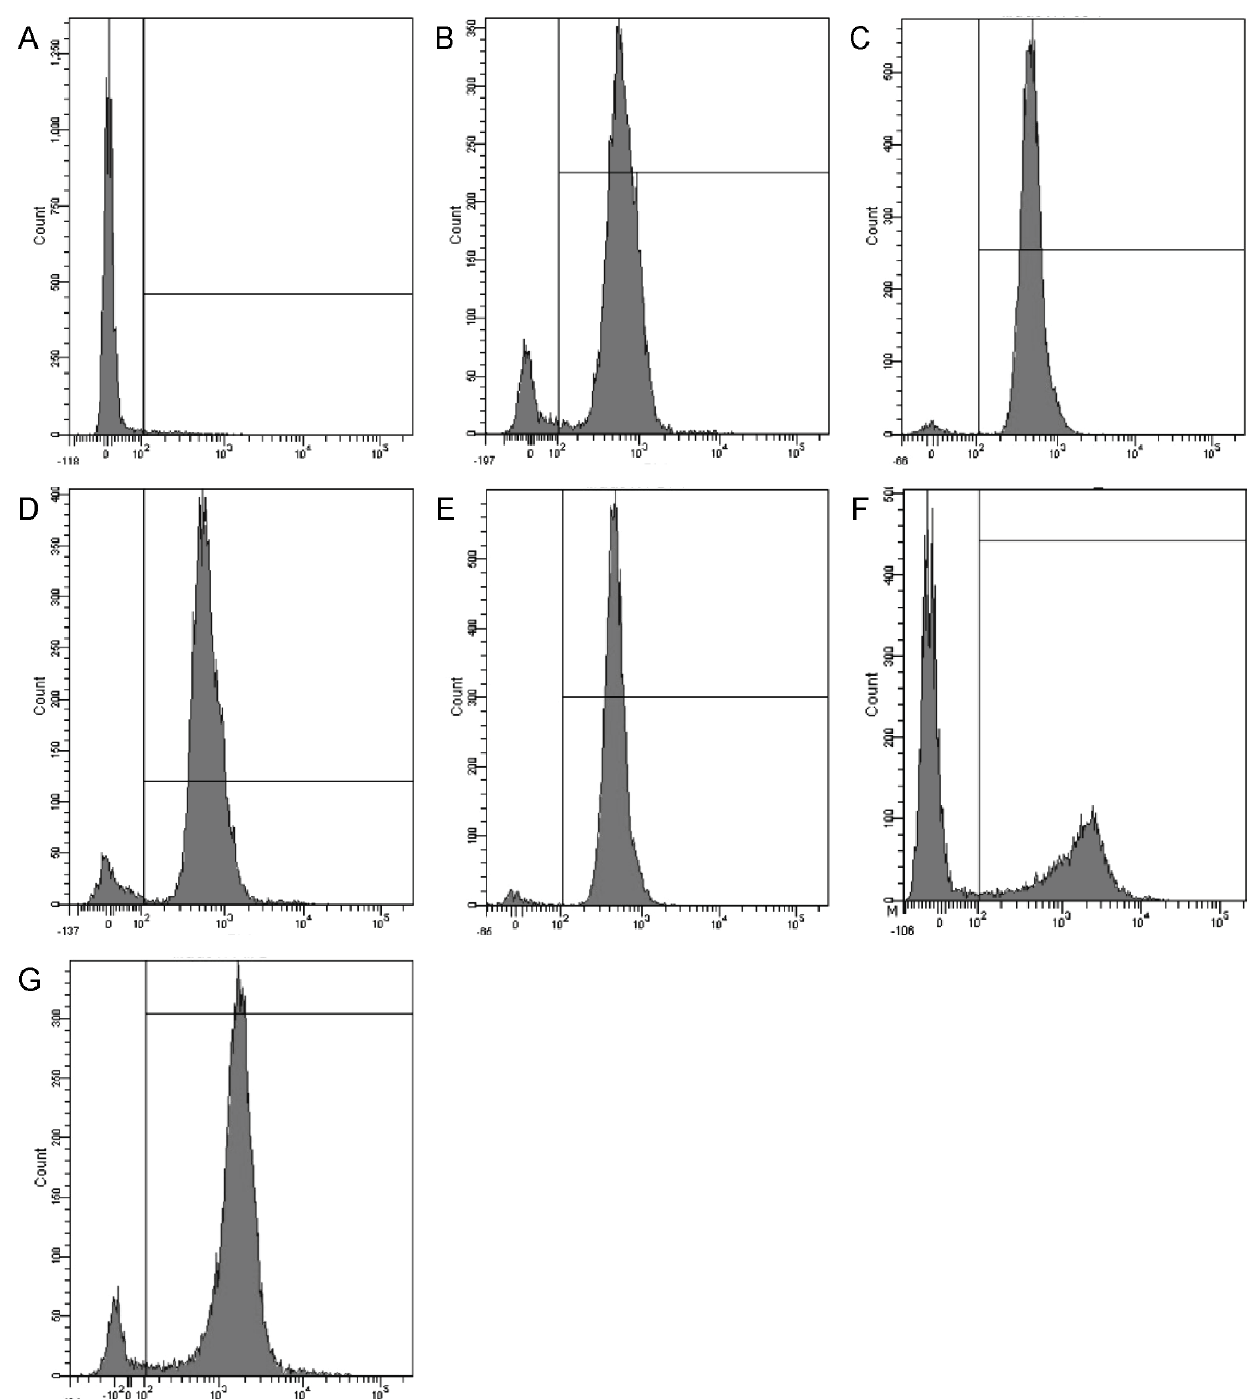
Figure 5. Flow cytometric analysis. The DNA intercalating dye propidium iodide (PI) was used to evaluate the cell membrane integrity via flow cytometry. The fluorescence intensity was monitored after treating with the peptides. Flow cytometry was performed using a FACScan instrument. (A) control, no peptide; (B) PMAP-36 (MIC, 1 m M); (C) PMAP-36 (2MIC, 2 m M); (D) GI24 (MIC, 1 m M); (E) GI24 (2MIC, 2 m M); (F) melittin (MIC, 2 m M); (G) melittin (2MIC, 4 m M). similar to GI24. We noticed that the antimicrobial activity of these W23A ( 2 3.26) and GI24-W23K ( 2 3.63). These results suggested peptides seem to be well correlated with their mean hydropho- that the hydrophobicity of an amino acid at position 23 played an bicity (Table 1). GI24 and GI24-W23L shared the same mean important role in determining the level of antimicrobial activity of hydrophobicity ( 2 2.81), which was higher than that of GI24-